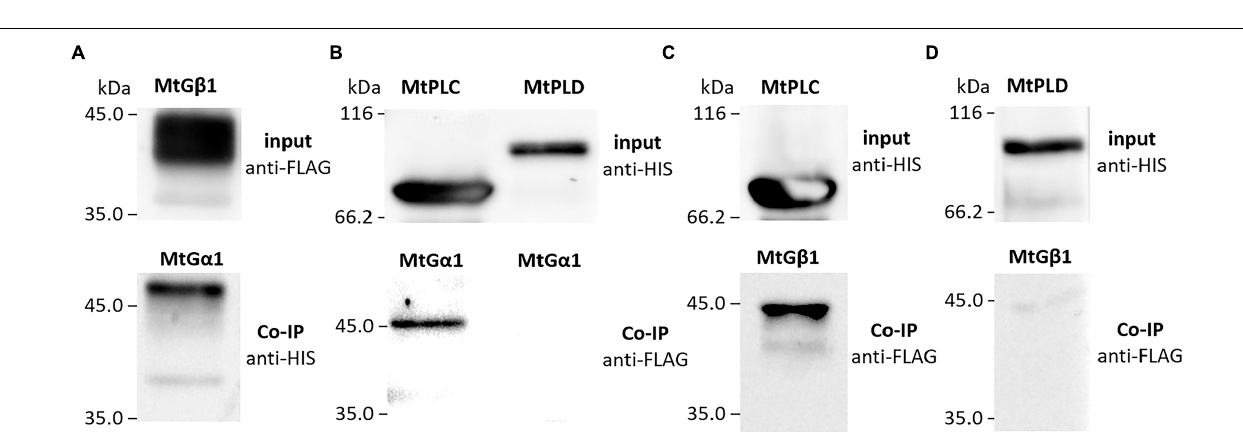
FIGURE 4 | The result of co-immunoprecipitation of heterotrimeric G-protein subunits and phospholipases C (MtPLC) and D (MtPLD) from M. truncatula . A heterologous protein expression was carried out in Escherichia coli C41, allowing high levels of expression of all subunits of interest (MtG beta1, MtG alpha 1, MtPLC, MtPLD) fused to either a 6xHIS or a 3xFLAG tag. The assays revealed interactions between MtG beta 1 and MtG alpha 1 (A) as well as MtG alpha 1 and MtPLC (B) , MtG beta 1 and MtPLC (C) . No interactions were detected between any of the G-protein subunits and MtPLD (B,D)